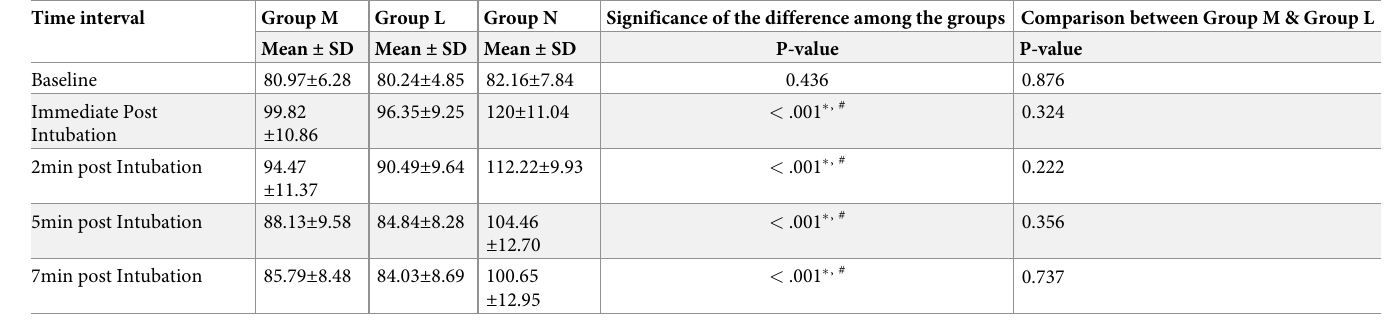
Comparison of mean SBP at different time points among magnesium sulphate, lido- caine, and non-exposed groups. There were no statistically significant intergroup differ- ences in baseline SBP among groups (p = 0.655). There was a statistically significant difference in mean SBP among groups at the all-time points. Post hoc analysis showed significant lower mean SBP at immediate, 2 nd , and 5 th minutes post-intubation in group M compared to Group L (p < 0.001, p = 0.001, p = 0.029), respectively. And there was also a statistically significant decrement in mean SBP when group M compared to group N at the immediate, 2 nd , 5 th (p < 0.001), and 7th minute post-intubation (p = 0.006) but there was no significant difference between two treatment groups at 7 th minute. There was also a statistically significantly lower mean SBP in group L compared with group N at all-time points except at 7 th minute (Table 3).